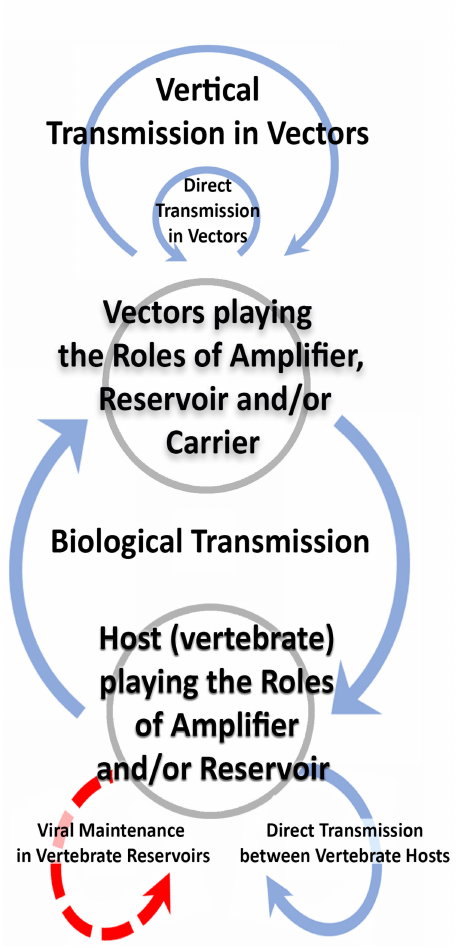
Figure 1. Generalized composite transmission cycle of RNA